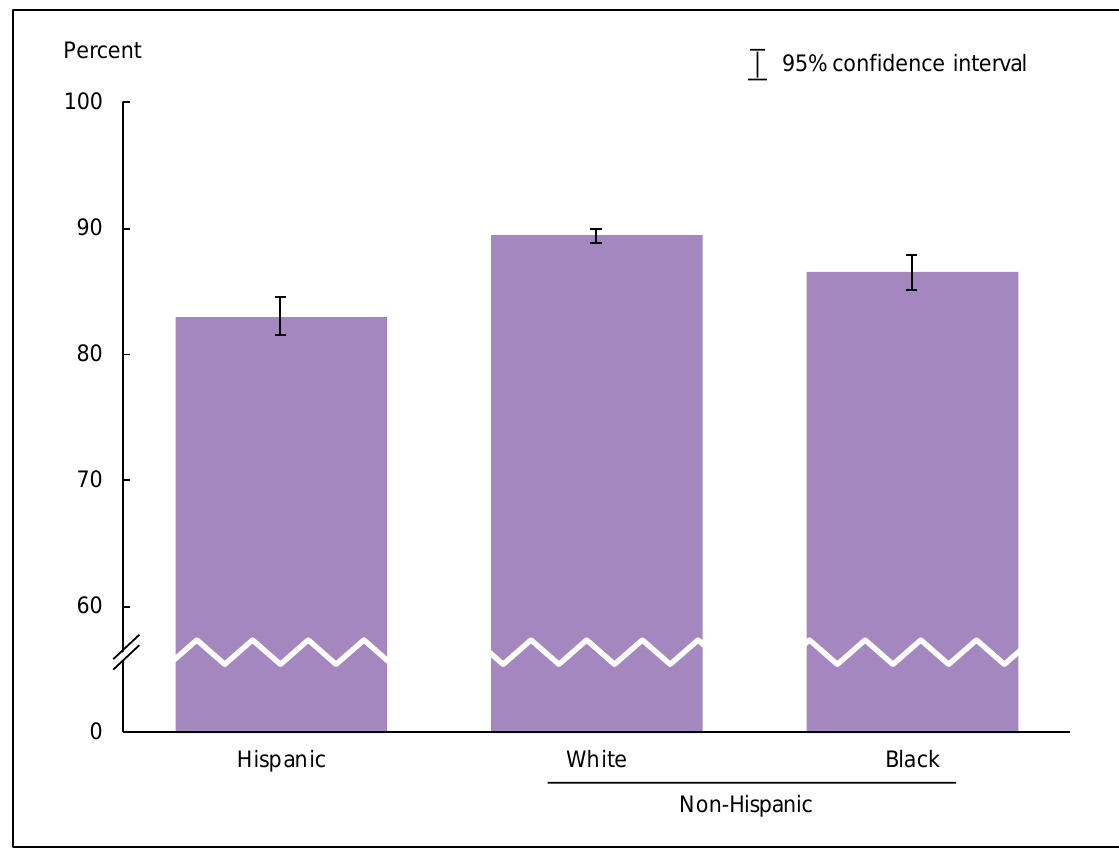
Figure 2.3. Age-sex-adjusted percentage of persons of all ages with a usual place to go for medical care, by race and ethnicity: United States,